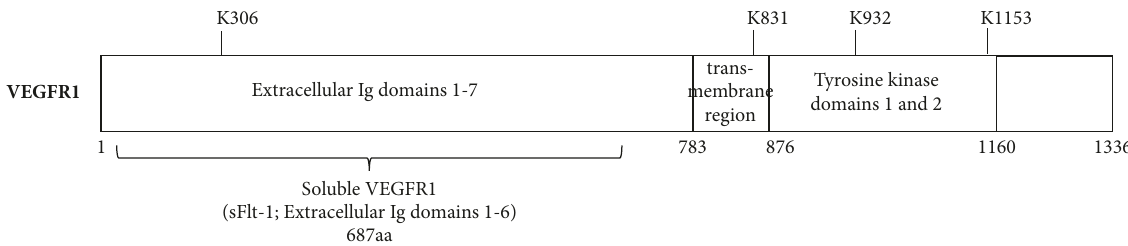
Figure 16: VEGFR1 lysine methylation sites (based on PhosphoSite